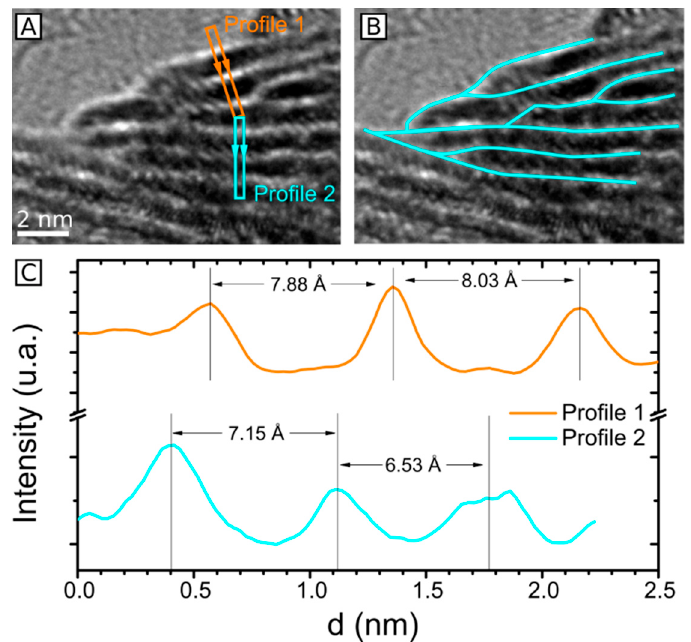
Figure 6. Close up of the HRTEM image from the left side of Figure 5 B, showing the MoS 3.4 lattice planes in cross section view. ( A ): Position of the intensity profile with a width of 10 px and direction marked by arrows. ( B ): Disclinations formed by merging MoS x layers are highlighted by cyan lines. ( C ): Intensity profiles indicated in A and exemplary variations in lattice distance. For the full analysis see Tables 2 and S5.